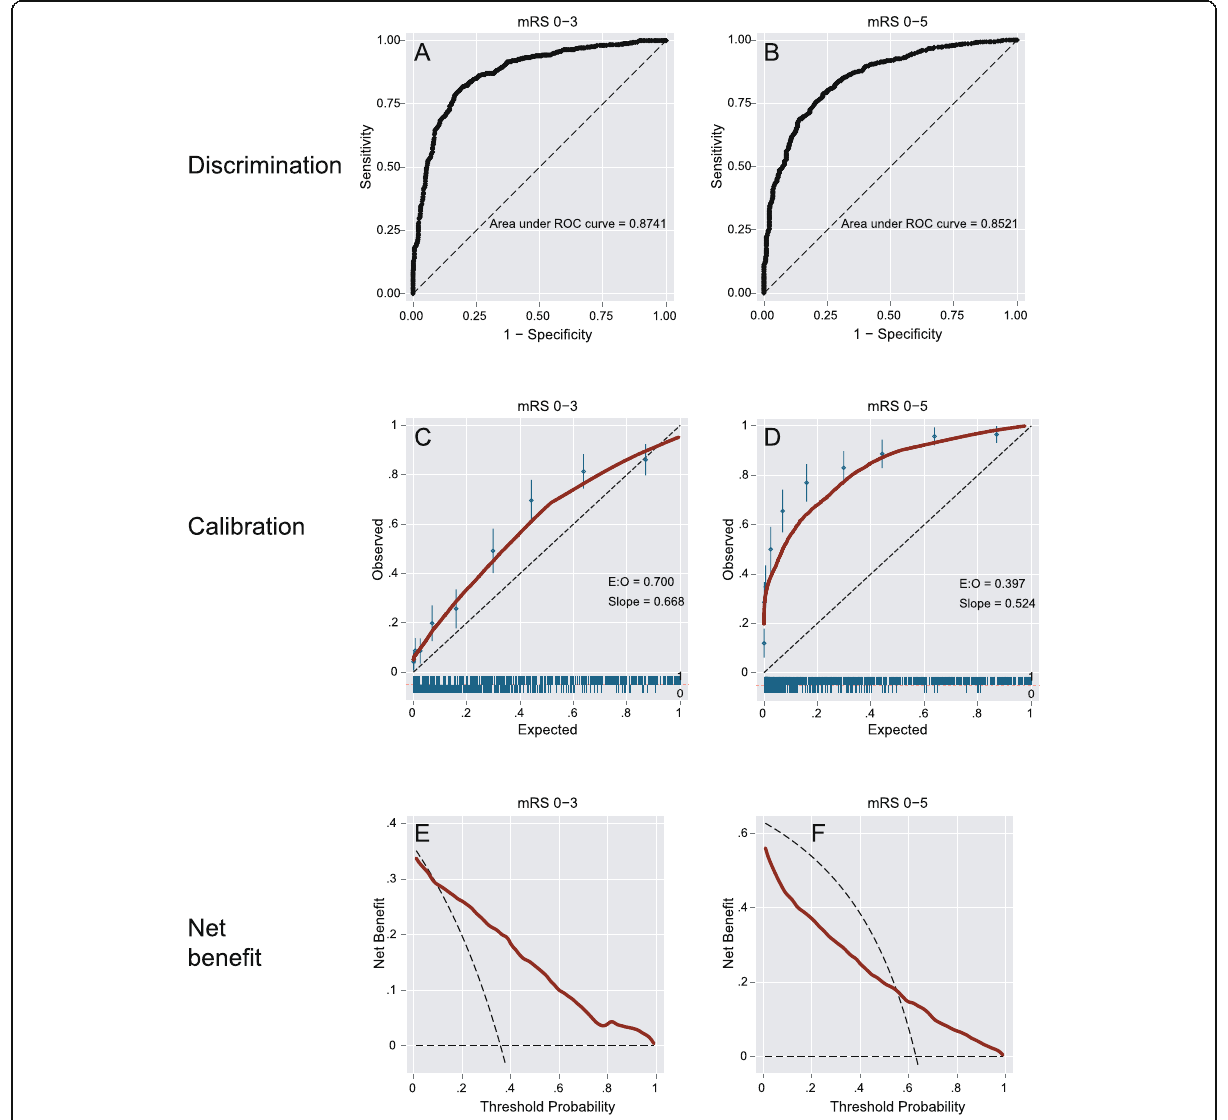
Fig. 2 Three validation measures. Discrimination (panel a + b ), calibration (panel c + d ) and net benefit analysis (panel e + f ) are shown for the outcomes mRS score 0 – 3 (left column), and mRS score 0 – 5 (=survival, right column). Panels c + d : the dotted indicates the ideal ratio where expected and observed outcomes are identical. The red line indicates the actually observed ratios. Panels e + f : the red line indicated the net benefit when using the Essen ICH score on the full range of threshold probabilities, the curved dotted line indicates the net benefit of treating all patients, and the straight dotted line on the x-axis indicated the net benefit of treating no one. Panel e shows an overall benefit (mRS 0 – 3) while panel f (mRS 0 – 5) does not indicate a clear benefit (red line mostly lower than the curved dotted line). Abbreviations: mRS modified Rankin scale, E:O expected/observed ratio, AUC area under the receiver-operating characteristic